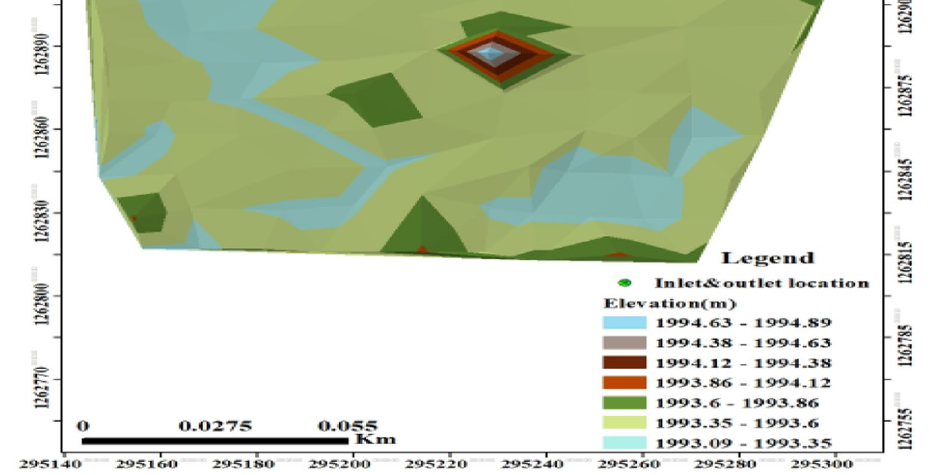
Table 5 Adebra NSR water surface area and storage capacity for 2012 and